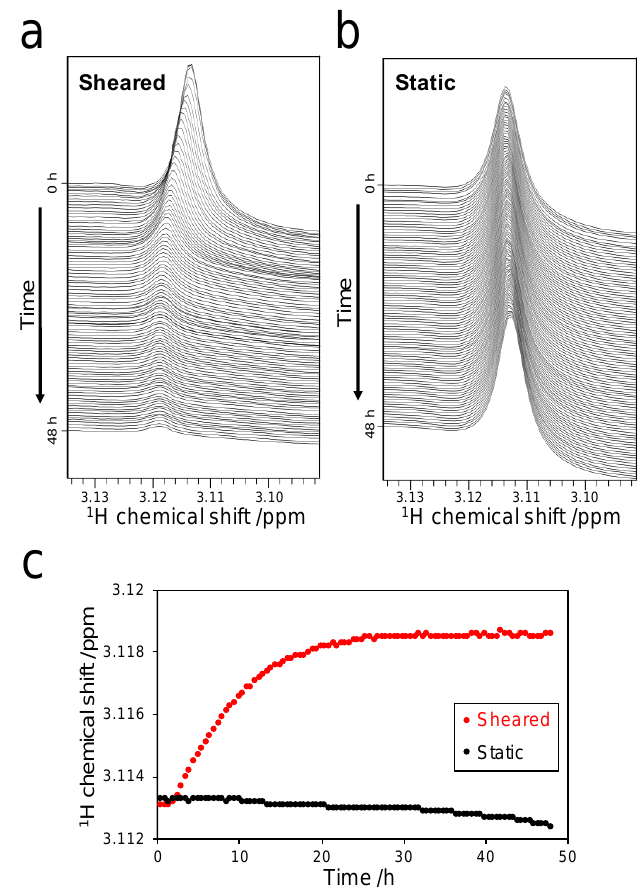
Figure 3. Detection of the weak interaction between ThT and the fibrils: Spectral changes in the range of 3.090 to 3.135 ppm under the sheared ( a ) and static ( b ) conditions. Spectra are displayed at intervals of 30 min; ( c ) Time-dependent chemical shift changes of the DMA peak under the sheared (red) and static (black) conditions.